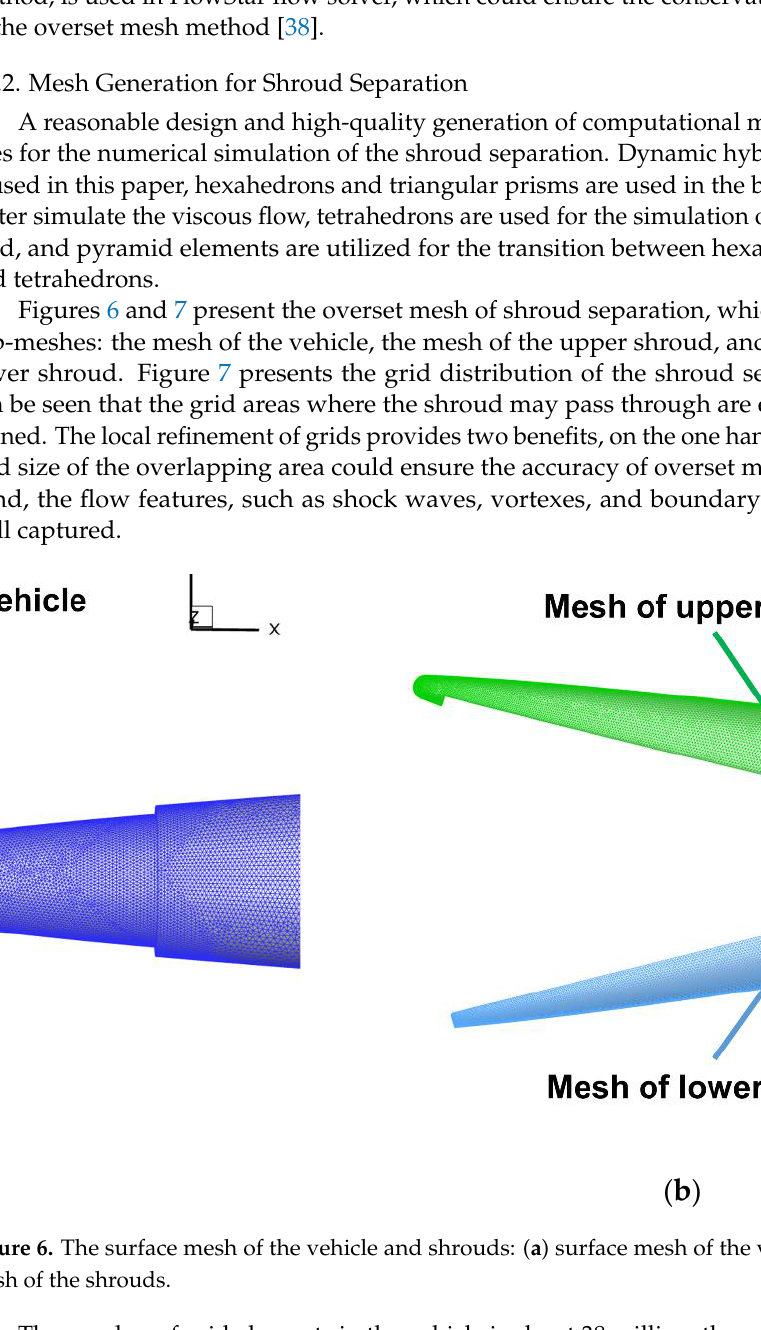
( b ) Figure 7. The overset mesh of shroud separation: ( a ) the three sub-meshes of shroud separation; ( b ) the grid distribution of the separation area. The number of grid elements in the vehicle is about 38 million, the number of the grid elements of the upper shroud and lower shroud is about 4 million, and the number of total grid elements is about 46 million. The grid scale of the first layer is 0.000004 m, according to the criterion of y+ < 1. Mesh independency will be studied in the next section. 3.3. Verifications and Validations 3.3.1. Mesh Independency Verification Three different sets of hybrid overset meshes, coarse mesh, medium mesh, and fine mesh, are built to verify the mesh independency. The meshes are different in the grid scale of surface and space. The number of total elements of the coarse mesh is about 31.0 million,